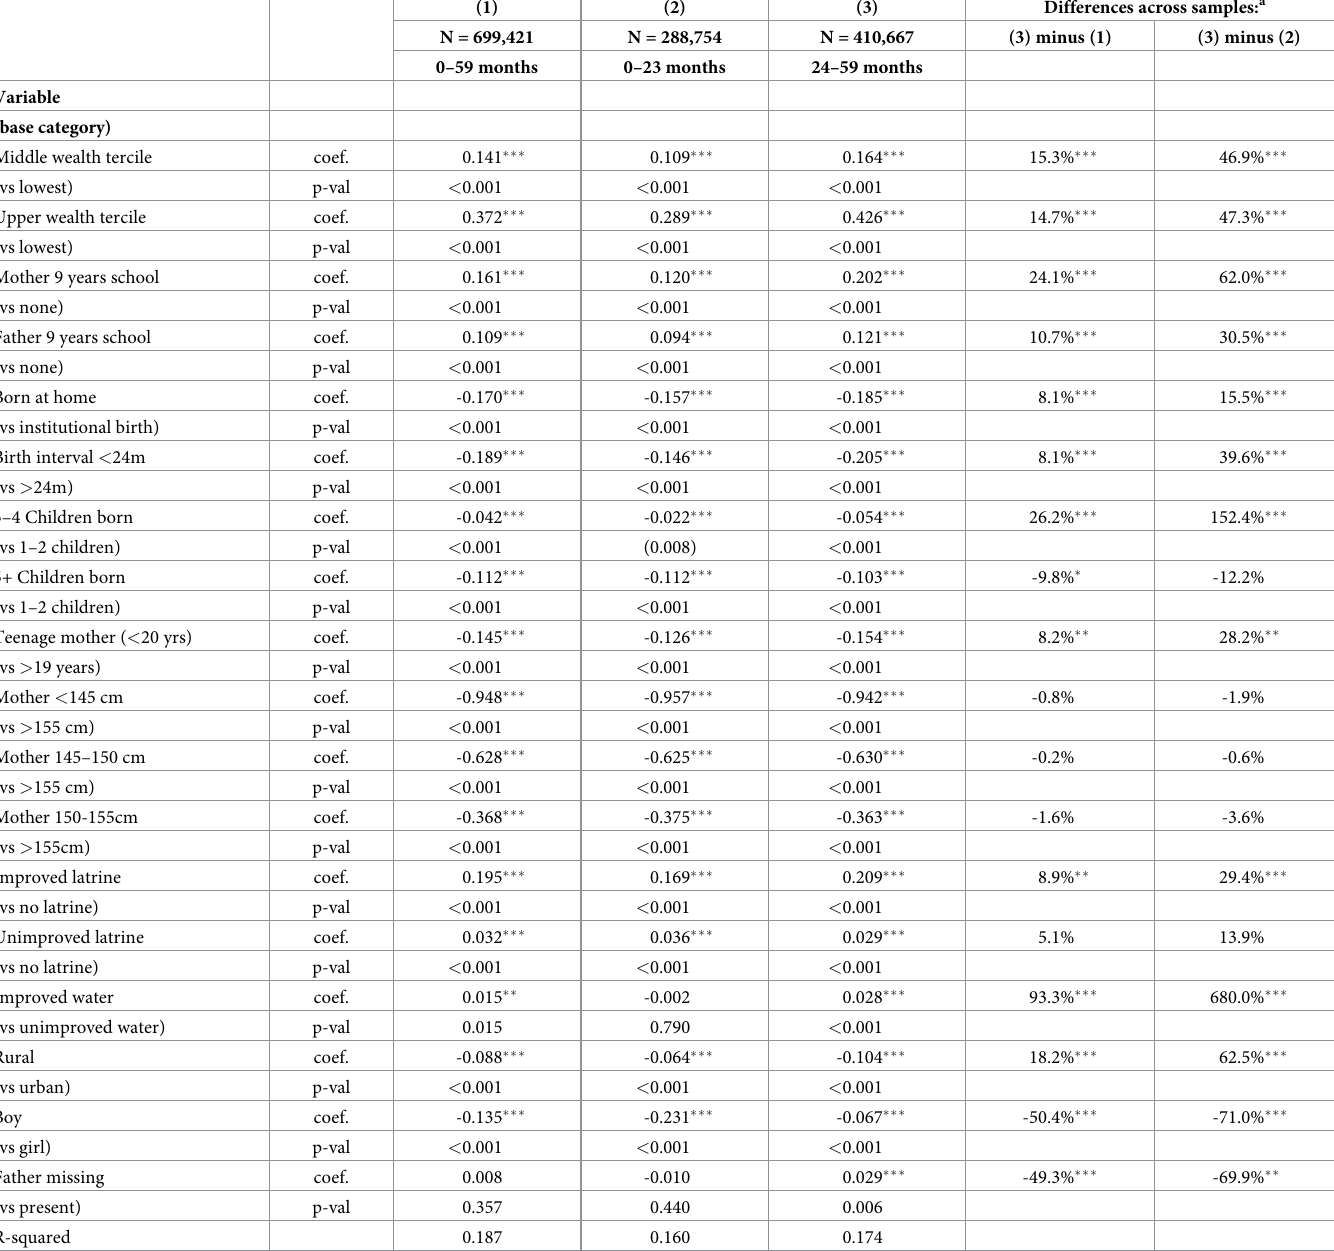
Table 2. Least squares regressions of child HAZ against standard explanatory variables for children aged 0–59 months, 0–23 months and 24–59 months from 57 developing